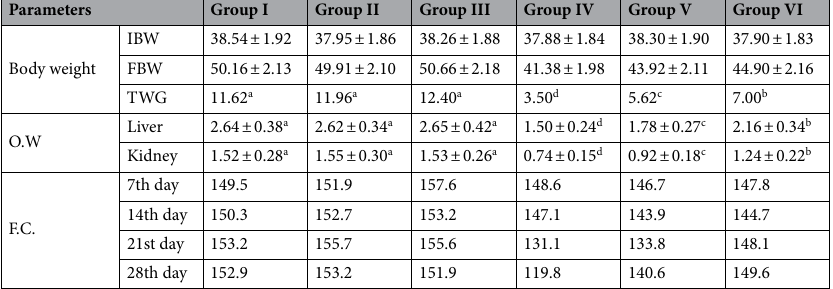
Table 1. The effects of AFM 1 and t-rsv on weight parameters and feed consumption. Group I: Control, Group II: 10 mg/kg b.w. t-rsv, Group III: 20 mg/kg b.w. t-rsv, Group IV: 16 mg/kg b.w. AFM 1 , Group V: 10 mg/kg b.w. t-rsv + 16 mg/kg b.w. AFM 1 , Group VI: 20 mg/kg b.w. t-rsv + 16 mg/kg b.w. AFM 1. Values are shown as mean ± SD (n = 6). The averages shown with different letters (a–d) on the same line are statistically significant (p < 0.05). IBW: Initial body weight (g), FBW: Final body weight (g), TWG: Total weight gain (g), O.W: organ weights, F.C: feed